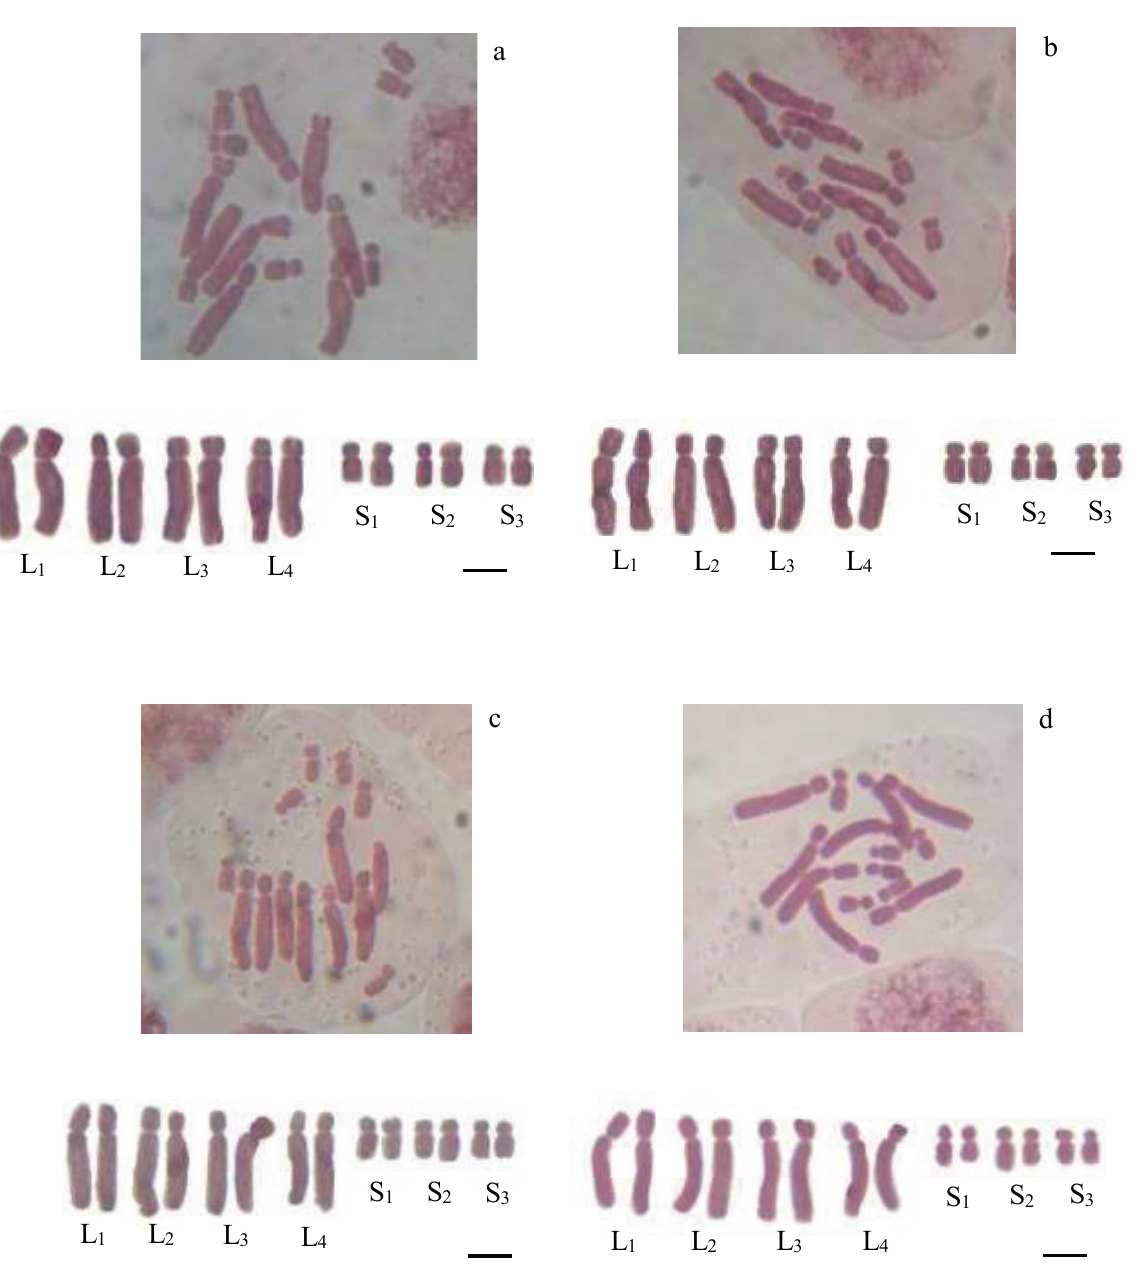
Figure 2. Mitotic chromosomes in root tip cells and bimodal karyograms (2 n =2x=14=8L+6S) of a) Aloe jucunda , b) A. vera , c, d) experi- mental hybrids with greater heteromorphisms between homologous chromosomes. Typing of large (L) and small (S) chromosomes accord- ing to Brandham (1971). Scale bars = 5